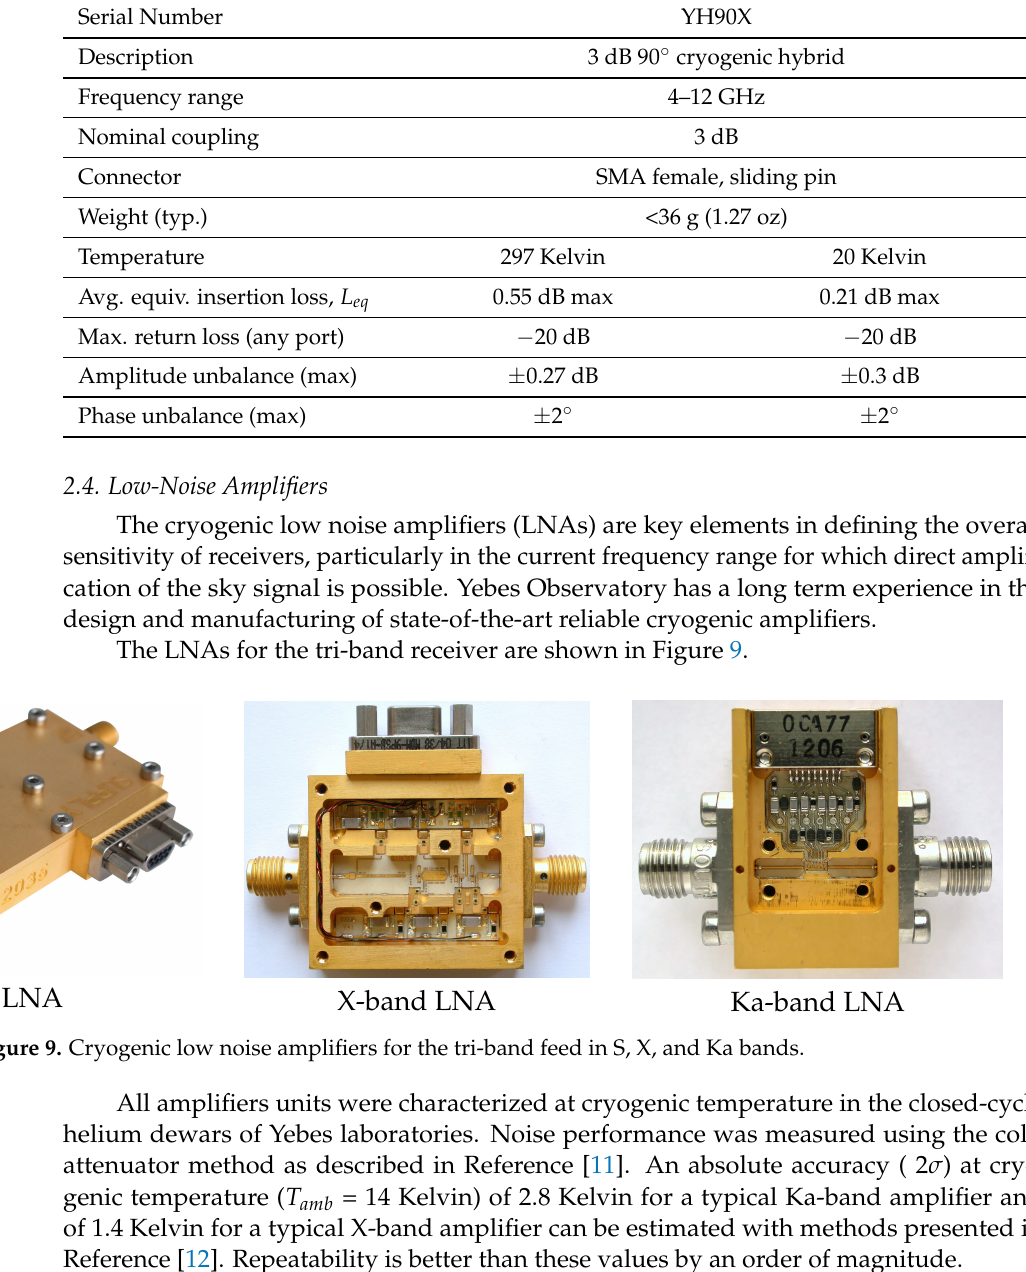
Table 3. Typical performance of tri-band receiver LNAs.